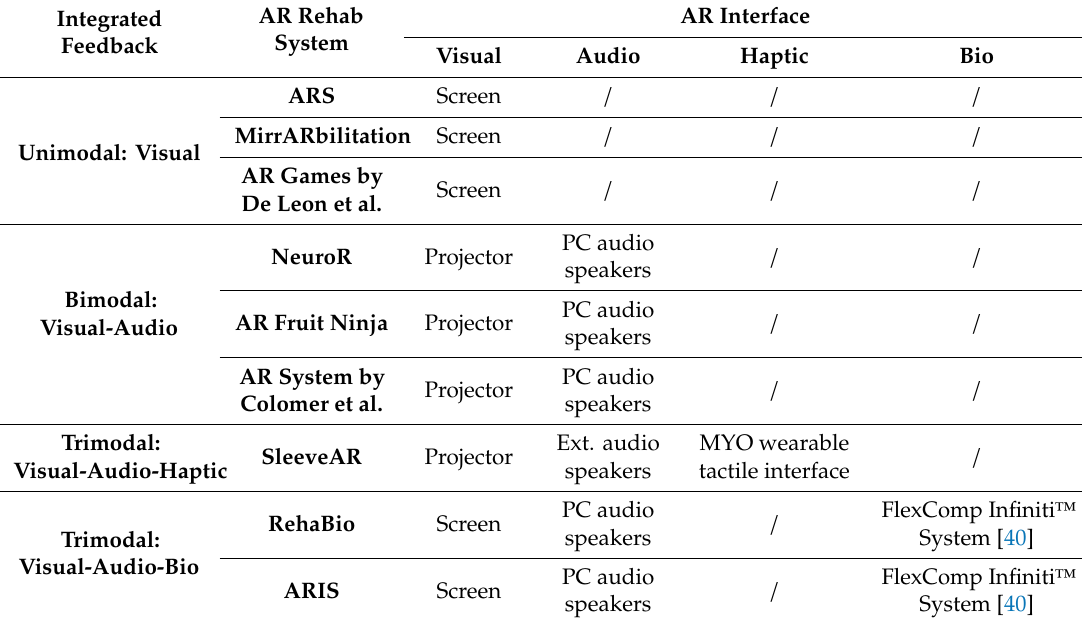
Table 3. Feedback modalities and interfaces of the AR Rehab Systems